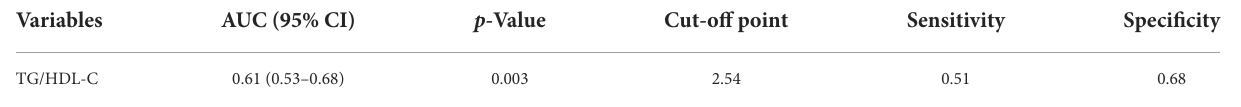
TABLE 4 Area under the receiver operating characteristic (ROC) curve (AUC), sensitivity, and specificity by the optimized cut-off point for triglyceride/high-density lipoprotein-cholesterol (TG/HDL-C) in predicting chronic kidney disease (CKD).